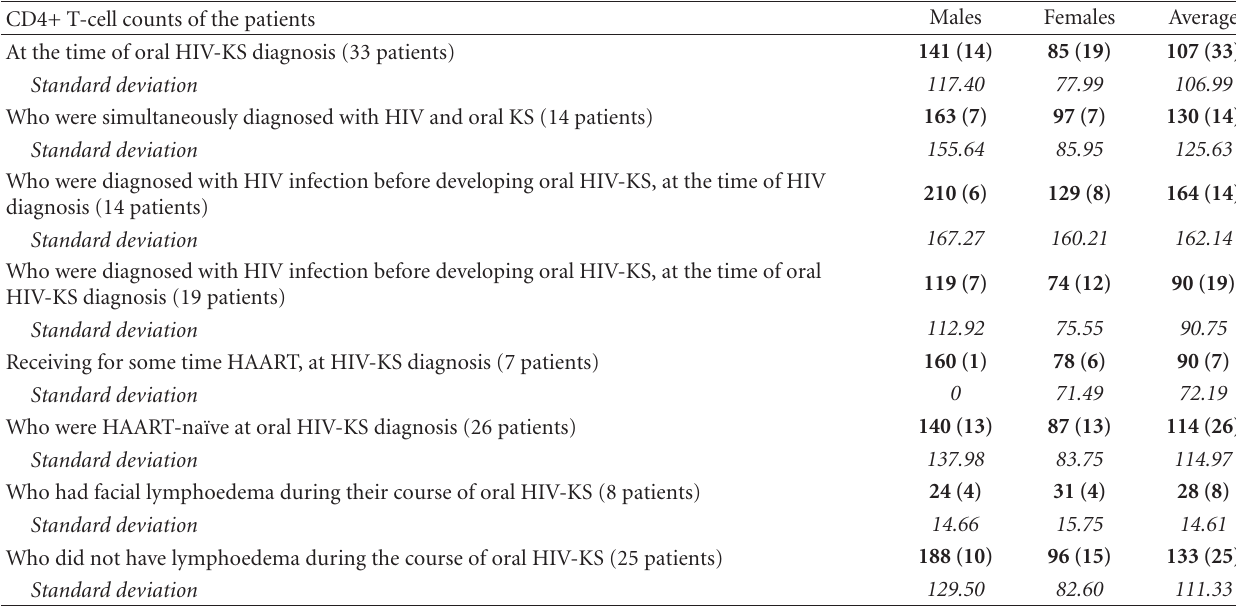
Table 3: CD4+ T-cell counts (cells/mm 3 ) of the